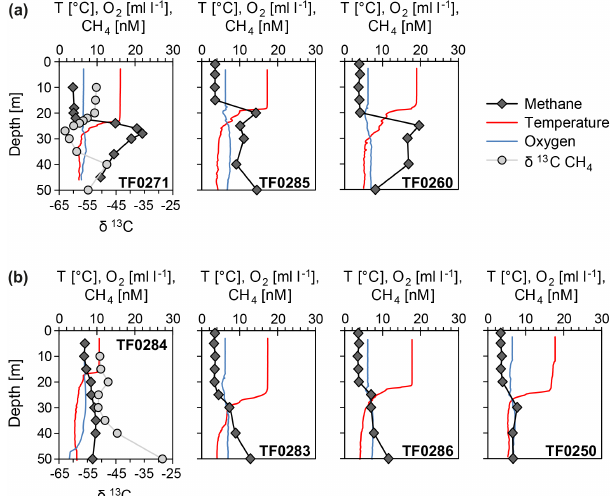
Figure 3. Vertical profiles of temperature ( T ), oxygen (O 2 ) and methane (CH 4 ) concentrations in the central Baltic Sea: (a) sta- tions with a distinct, and (b) stations without a distinct subthermo- cline methane enrichment; stable carbon isotope values of methane ( δ 13 C) are presented for station TF0284 (western Gotland Basin) and TF0271 (eastern Gotland